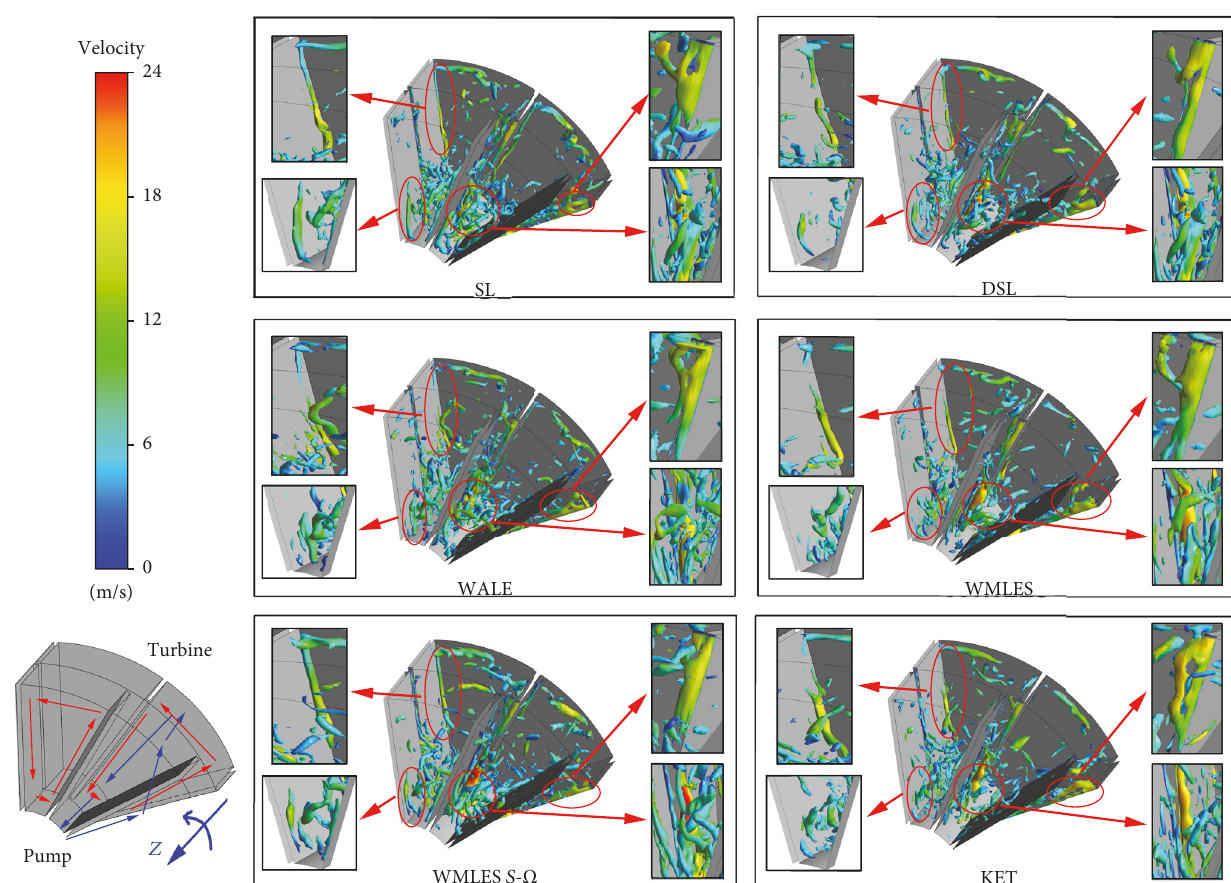
Figure 7: The vortex structures and flow field in the